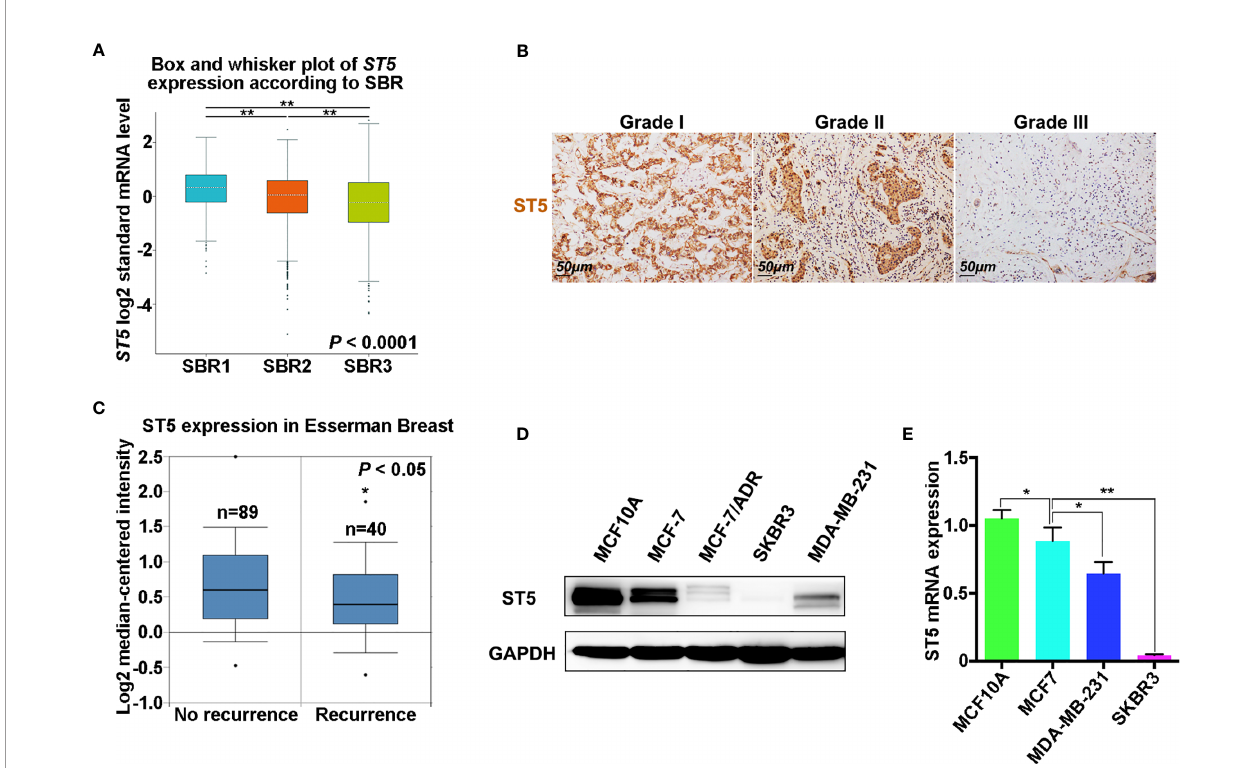
FIGURE 2 | Expression analysis of ST5 in different breast cancer specimens and cells. (A) Analysis of ST5 expression status in different tumor grades according to Scarff Bloom and Richardson (SBR) classi fi cation as determined by using bc-GenExMiner v4.4. ** indicated SBR1 or SBR3 vs. SBR2 and SBR3 vs. SBR1. (B) Immunohistochemical staining using ST5 primary antibody in different pathological grades (Grade I, II and III) of human breast cancer tissue (tissue microarray). Scale bar, 50 m m. The brown areas indicated ST5-positive cells. (C) Differential expression of ST5 in non-recurrent or recurrent breast cancer patients in Esserman Breast using Oncomine database. * indicated Recurrence vs. No recurrence. (D) Protein level of ST5 in MCF-7, MCF-7/ADR, MDA-MB-231, SKBR3 cells and normal breast cells (MCF-10A) were determined by Western Blotting. MCF-10A, normal mammary epithelial cell line; MCF-7, ER-positive breast cancer cell; MCF-7/ ADR, adriamycin resistant MCF-7 cells; MDA-MB-231, ER-negative cell line; SKBR3, ER/PR-positive and Her2-negative breast cancer cell lines. (E) Transcriptional level of ST5 in MCF-7, MDA-MB-231, SKBR3 cells and MCF-10A were determined by qRT-PCR. * indicated MCF-7 vs. MCF-10A and MDA-MB-231 or SKBR3 vs . MCF-7. *P < 0.05; **P <